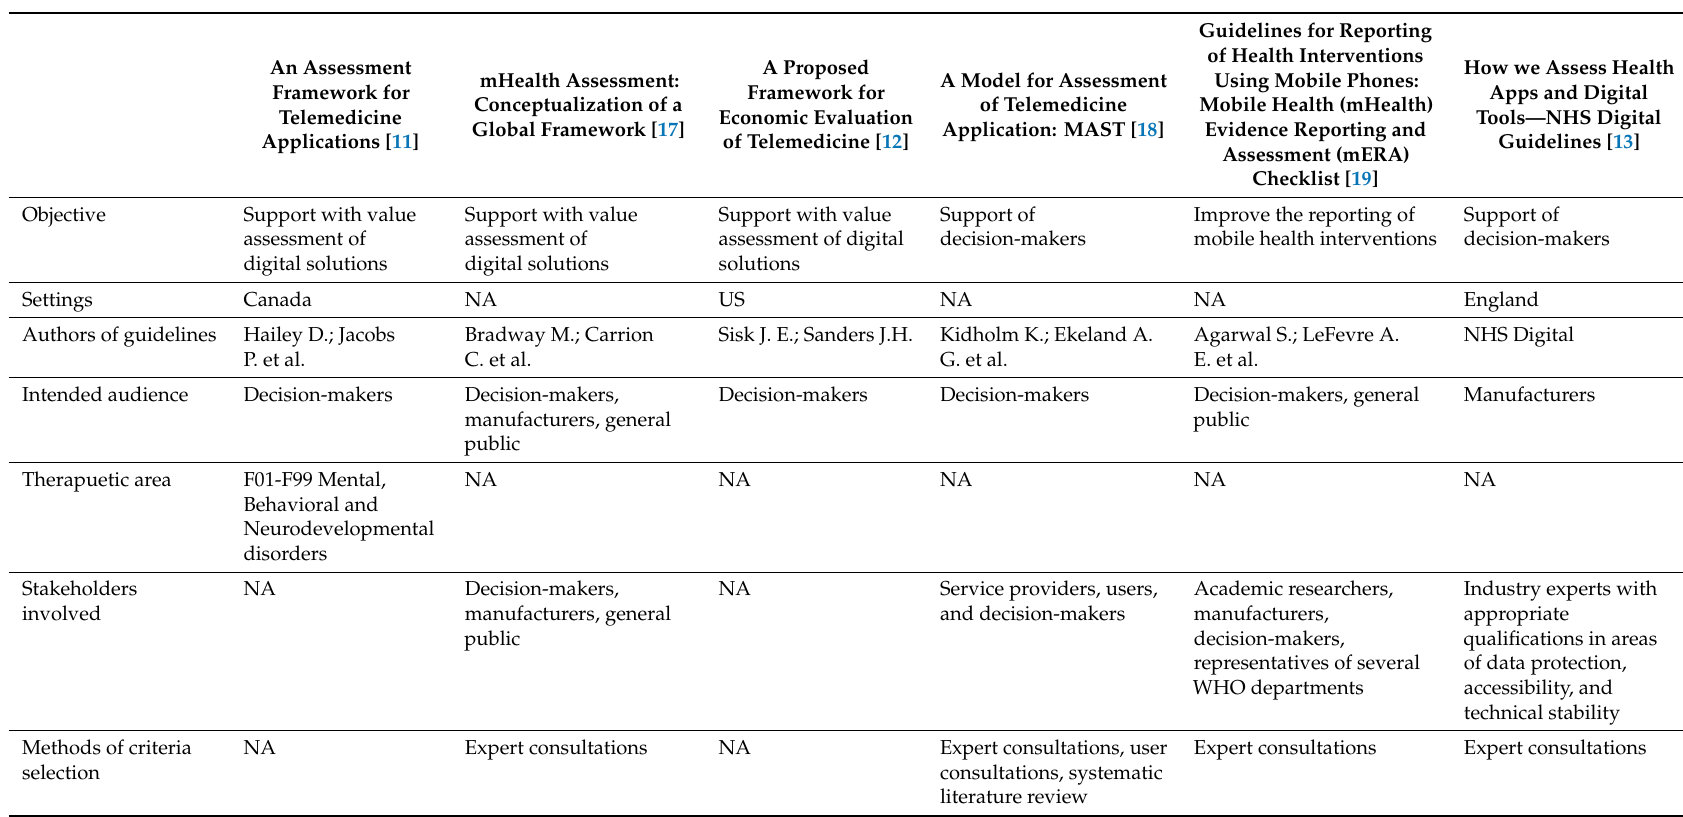
Table A1. General